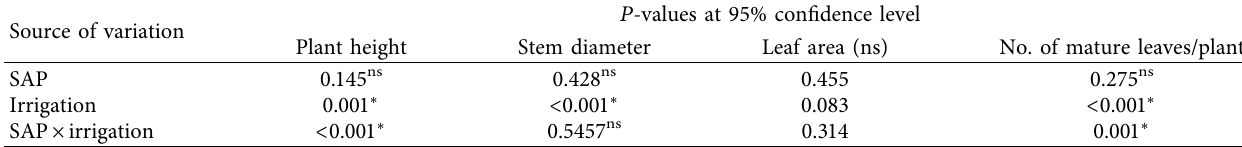
Table 3: ANOVA for dependent variables and their interaction with cowpea plant at 95% confidence level.